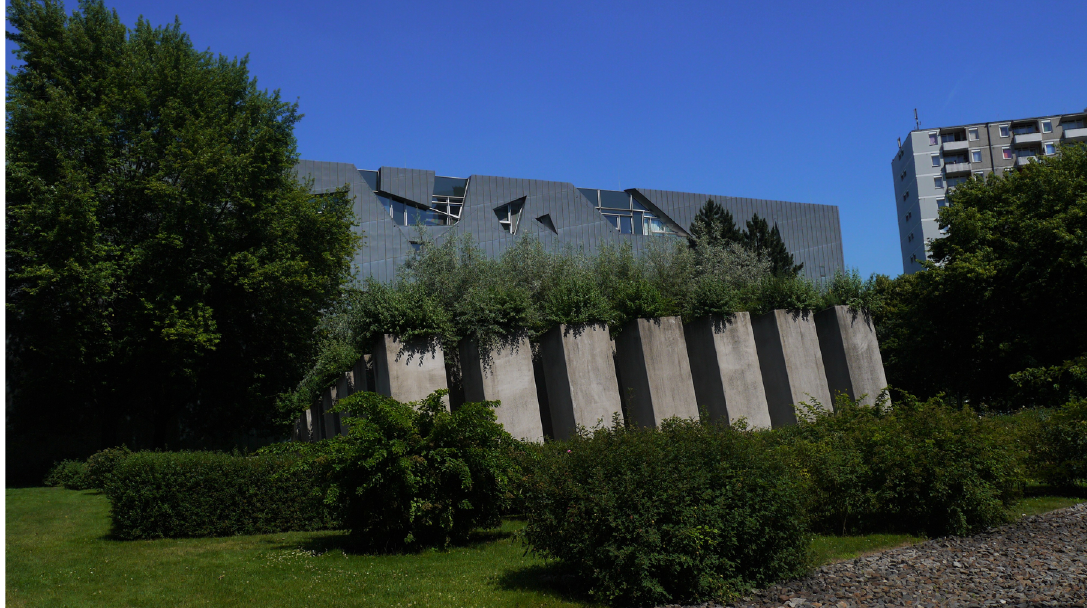
Figure 3. The Garden of